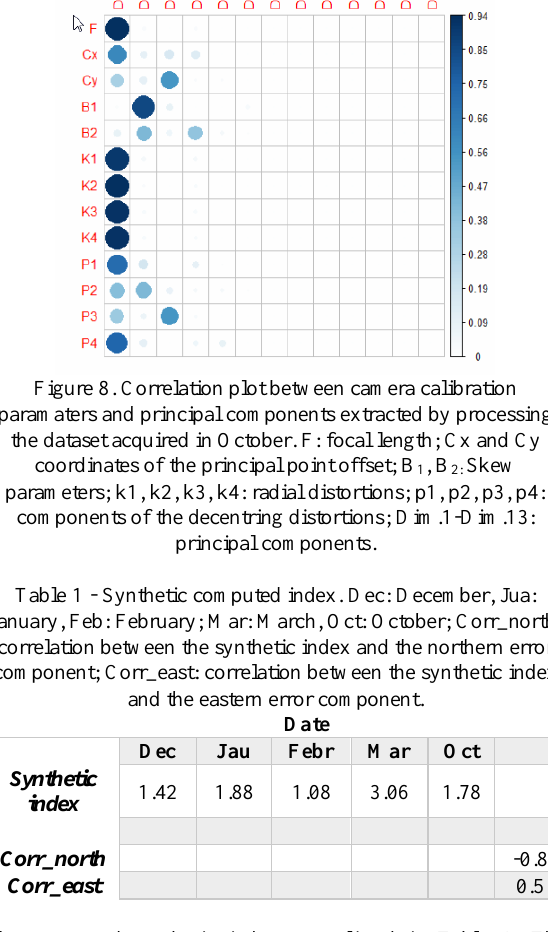
The computed synthetic index were listed in Table 1. The correlation between them and the eastern and northern error components were computed as well and also reported in Table